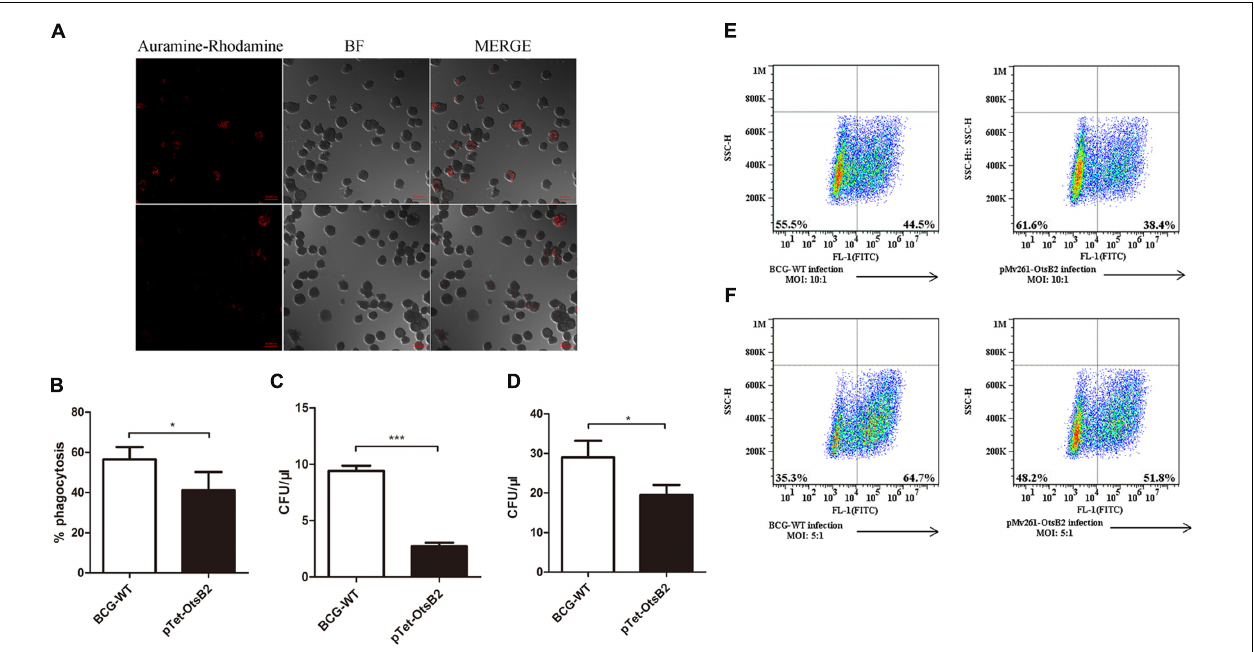
FIGURE 1 | BCG-OtsB2 is phagocytosed less than WT BCG by THP-1 macrophages. (A) Confocal microscopy of Auramine O-stained WT BCG (upper panels) and BCG-OtsB2 (lower panels) following phagocytosis (MOI: 5:1) by activated THP-1 macrophages. (B) Numerical analysis of confocal data. (C) Survival by plated CFU of BCG and BCG-OtsB2 following phagocytosis by THP-1 macrophages for 2 h and (D) 24 h. MOI: 5:1. Phagocytosis analysis by flow cytometry of BCG vs BCG-OtsB2 at MOI 10:1 (E) and 5:1 (F) . ∗ p < 0.05, ∗∗∗ p < 0.001 by Student’s t -test. Results representative of at least three separate experiments.